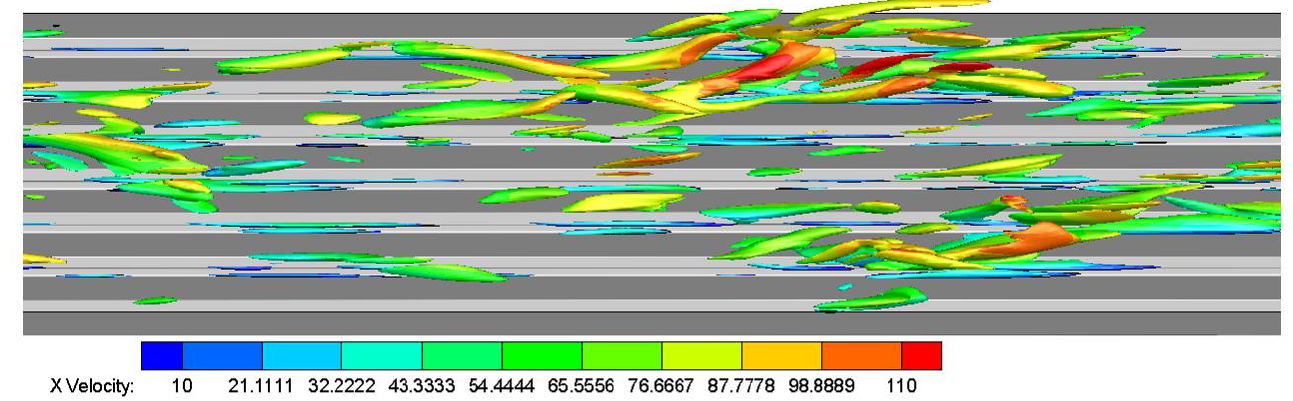
Figure 28. The λ isosurface of the flow velocity cloud picture of the rectangular groove, λ = − 6.53 × 10 10